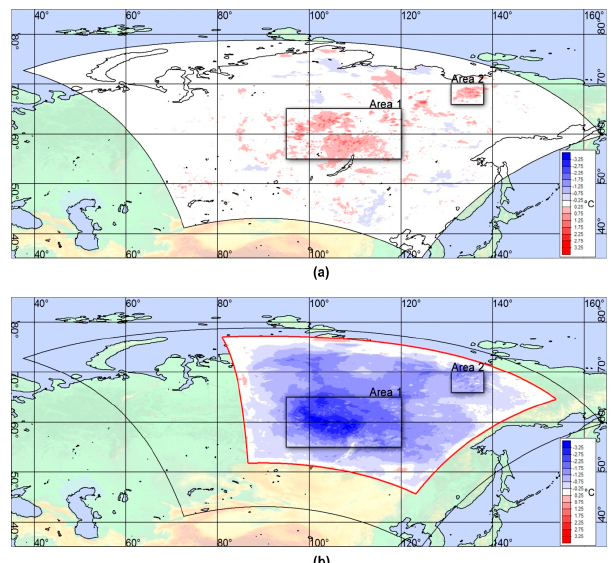
Figure 5. Spatial distribution of mean air temperature differences at 2 m height from 1–14 August 2019: ( a ) between forest fire experiment 2 (without ART) and control experiment, ( b ) between forest fire experiment 3 (with ART) and control experiment.